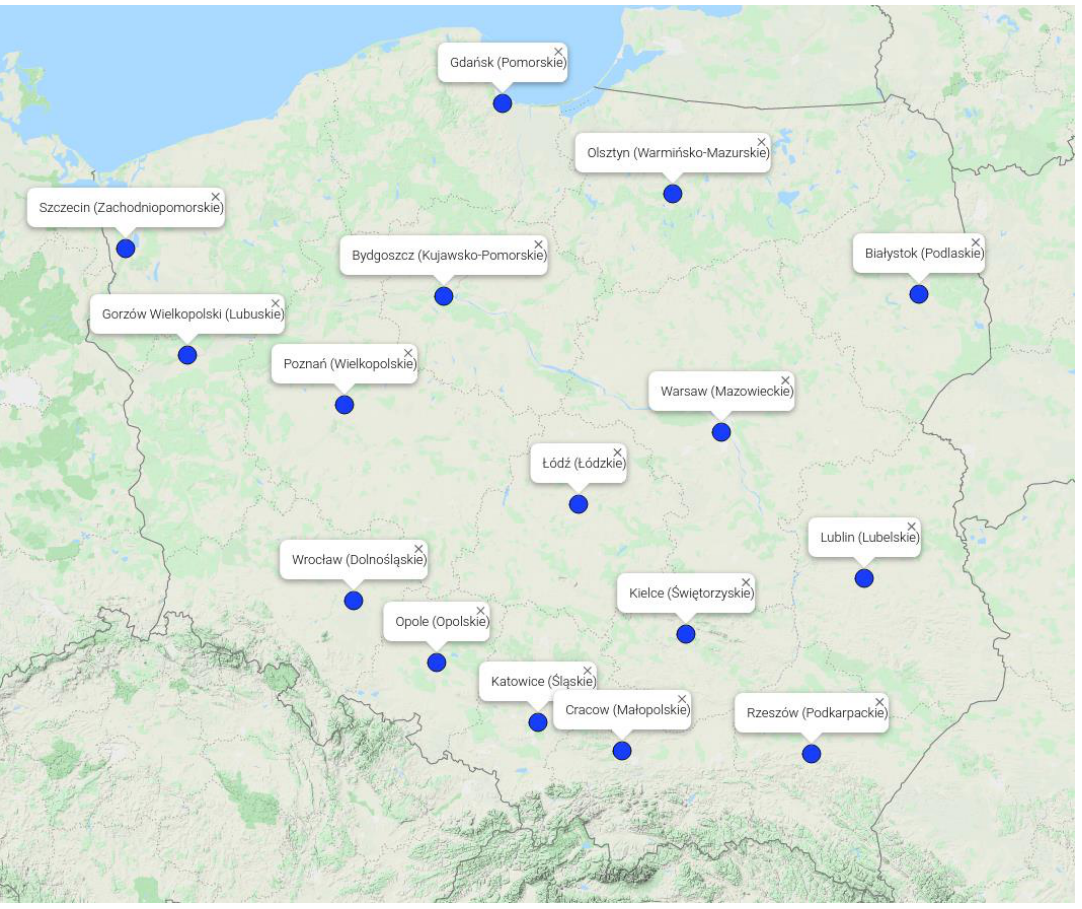
Figure 1. Locations of the capitals of the voivodeships. The name of the voivodeship is provided in brackets. Table 1. General geographical and demographical characteristics of voivodeships of Poland.